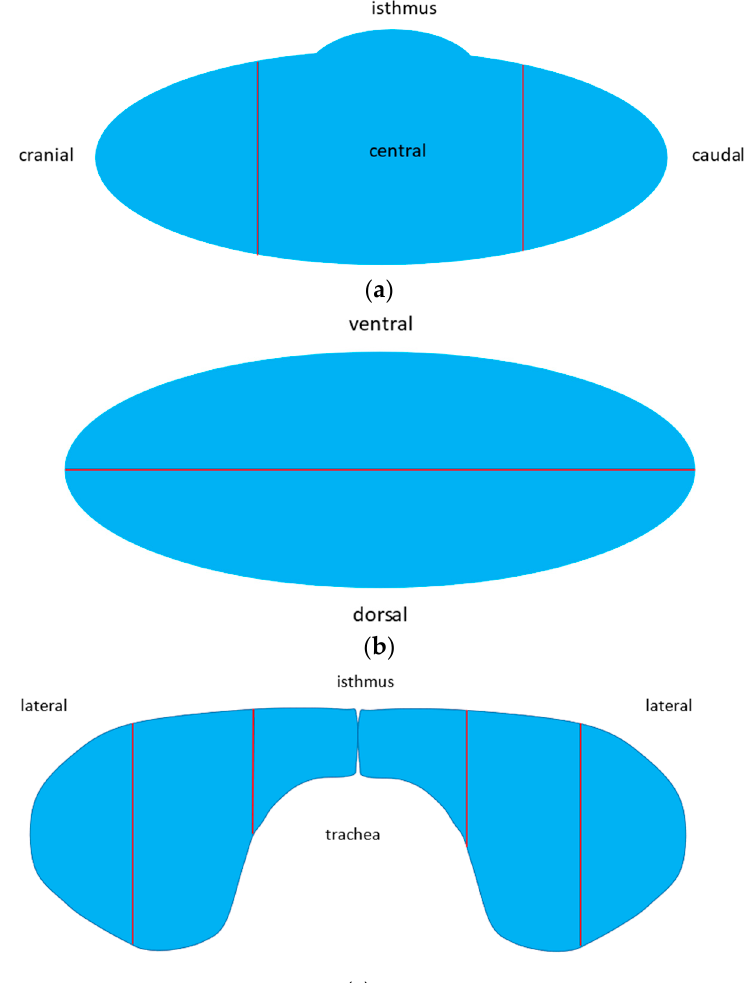
Figure 1. ( a ) Dimension craniocaudally: cranial–central–caudal. ( b ) Dimension ventrodorsally: ventral–dorsal. ( c ) Dimension horizontally: lateral–medial (isthmus).